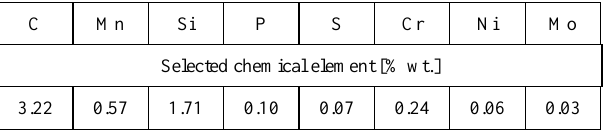
Table 1. Chemical composition of the analyzed brake disc